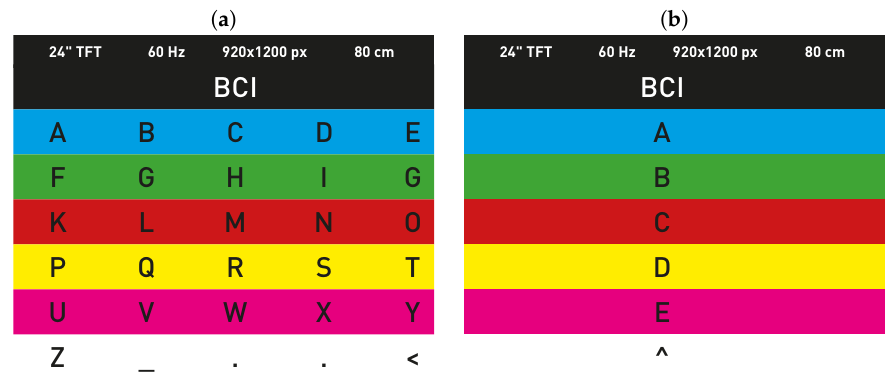
Figure 4. Chroma Speller in its two operating stages [74]. ( a ) The first-stage selection. ( b ) The second stage to select an individual character. The target word here was suggested to be “BCI”, and “B” is the target letter. Figures modified from [74].